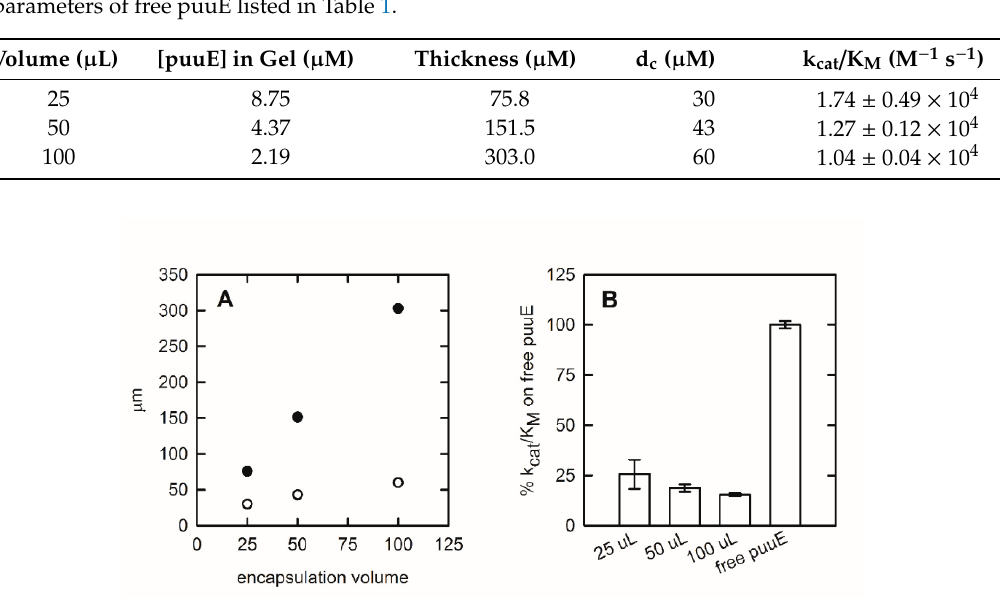
Figure 4. Silica matrix parameters and puuE activity after entrapment in different sol-gel volumes. ( A ) Comparison between sol-gel thickness (closed circles) and matrix critical thickness (open circles) immobilizing 7.75 µg of puuE in increasing matrix volumes. ( B ) Catalytic efficiency of puuE encapsulated in increasing matrix volumes with respect to the free enzyme. For each condition of encapsulation, the experiments were carried out in triplicate and data were collected from single-wavelength CD kinetics at 210 nm in the presence of 0.2 mM racemic allantoin 20 in mM potassium phosphate, pH 7.4, at 37 °C.